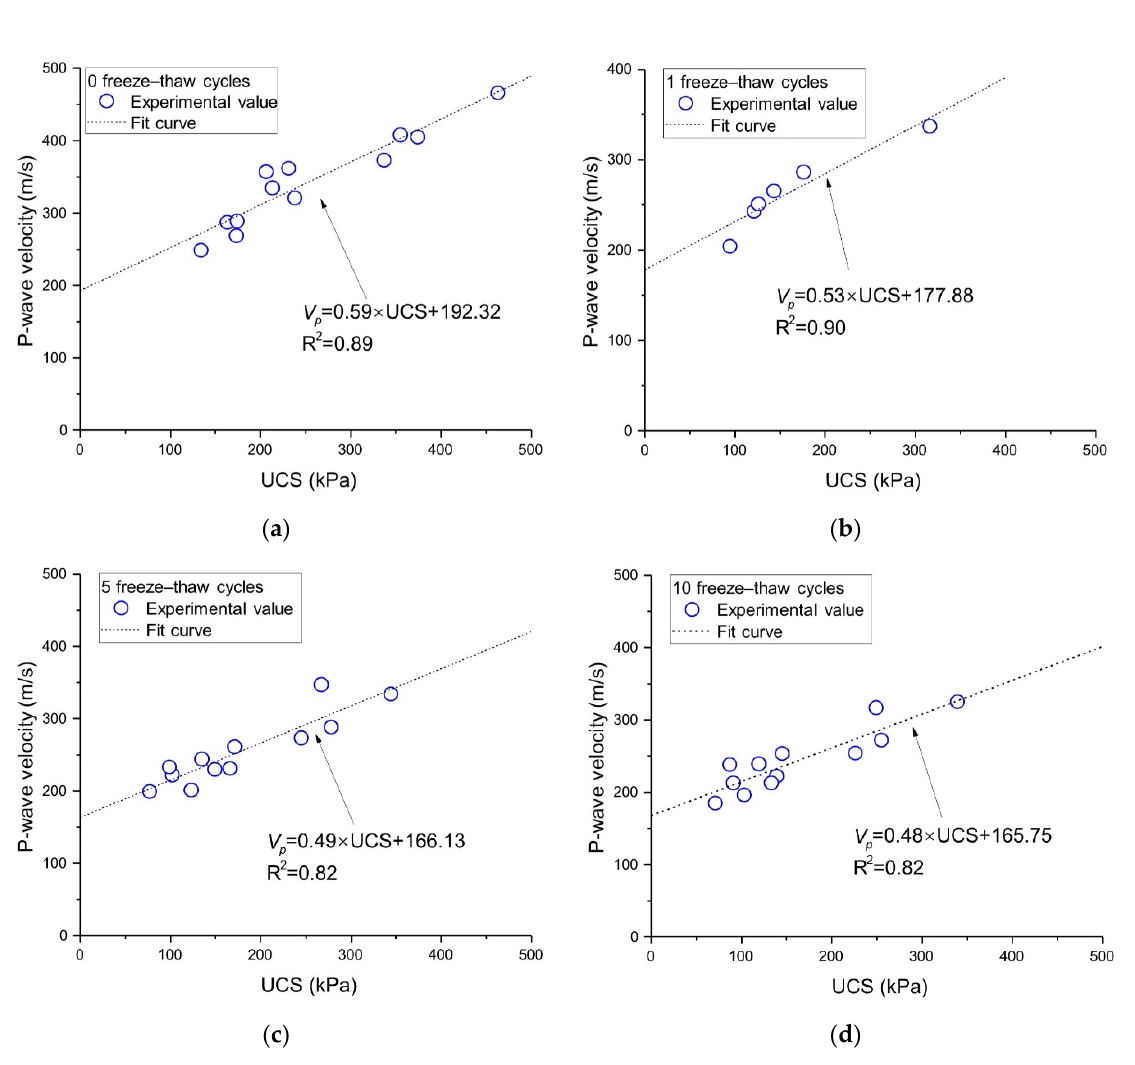
Figure 12. Relationship between V p and UCS: ( a ) FC = 0, ( b ) FC = 1, ( c ) FC = 5, and ( d ) FC = 10.